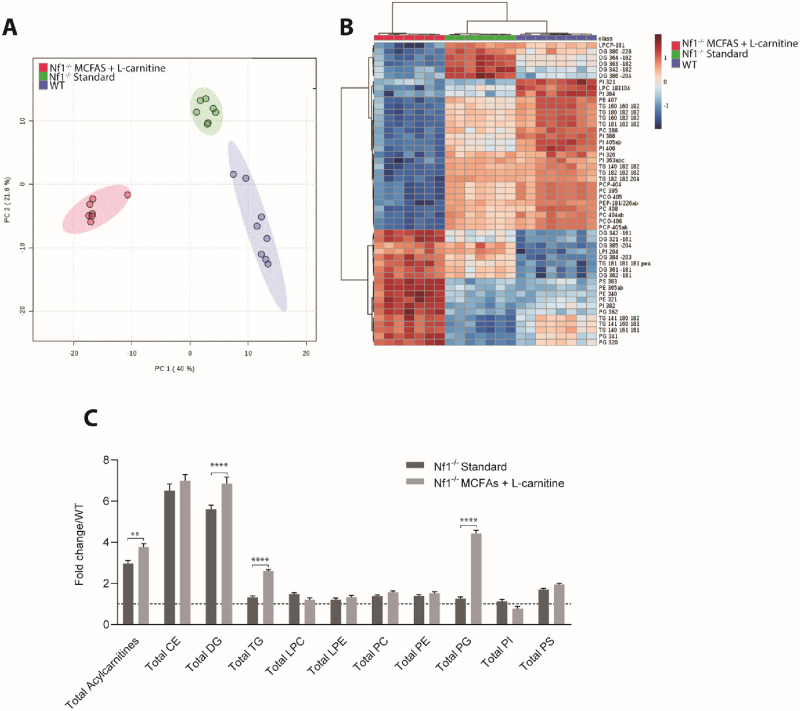
Lipidomics analysis of whole quadriceps of MCFA + L-carnitine fed Nf1Prx1-/- mice confirms dietary intervention can alter lipid metabolism.(A) Principal-component analysis of LC-MS data showed group clustering and separation of lipid data between WT, Nf1Prx1-/- mice fed standard chow and Nf1Prx1-/- fed MCFA + L-carnitine chow. The first two components captured >60% of the variance across the dataset (PC1: 40%, PC2: 21.6%). (B) Heat map analysis of the top 50 lipid species selected based on fold change suggests increased TG and DG species. (C) Total DG, TG and PG are increased in whole quadriceps of Nf1Prx1-/- fed MCFA + L-carnitine chow. Total acylcarnitines are elevated in Nf1Prx1-/- mice, which were exacerbated upon MCFA dietary enrichment and carnitine supplementation. n = 8 quadriceps muscle samples analyzed for all lipidomics studies. Data presented as group mean ± SEM fold change compared to WT. p-values were assessed by ANOVA. **** p <0.0001 ** p<0.003. CE; Cholesterol esters, DG; Diglycerides, TG; triglycerides, LPC; Lysophosphatidylcholine, LPE; Lysophosphatidylethanolamine, PC; Phosphatidylcholine, PE; Phosphatidylethanolamine, PG; Phosphatidylglycerol, PI; Phosphatidylinositol, PS; Phosphatidylserine.